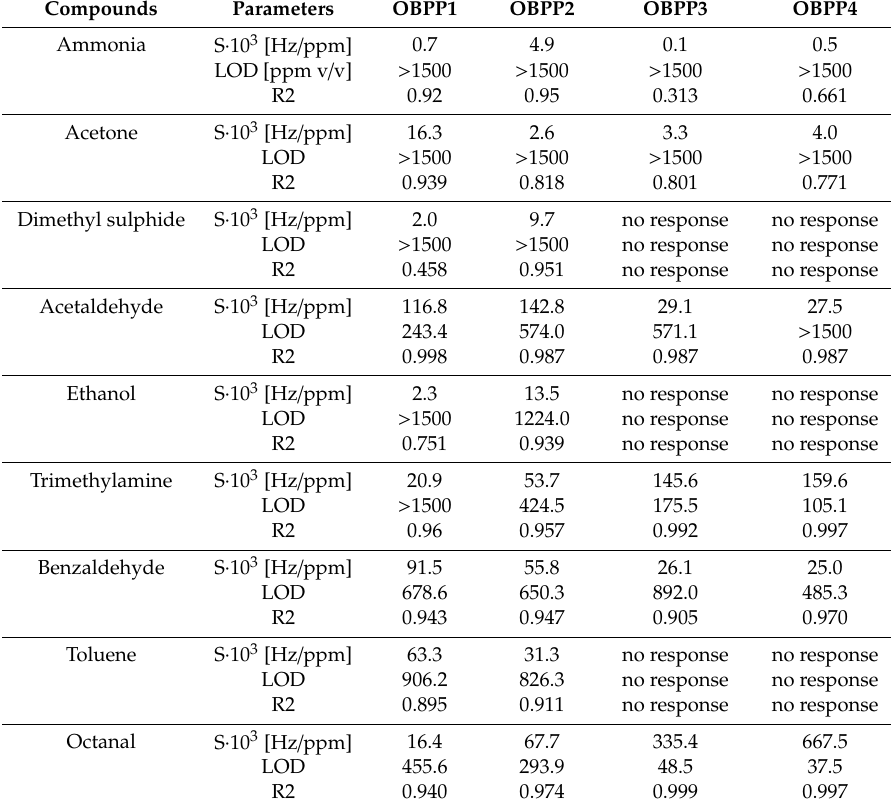
Table 2. Comparison of biosensors’ responses to di ff erent